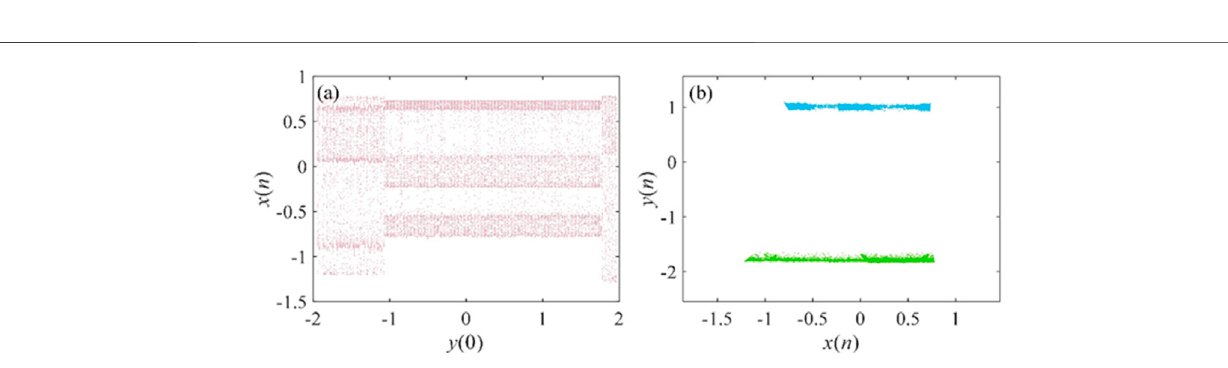
FIGURE 8 | Experimental results graph when a = 0.69. (A) Bifurcation with initial value y (0); (B) Attractors coexistence phase